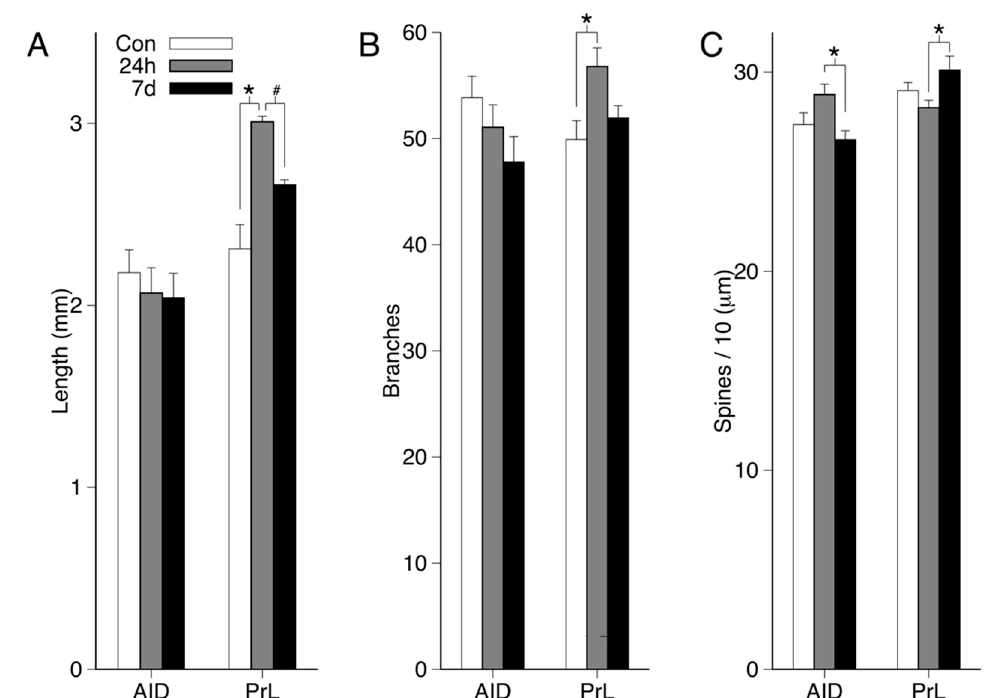
Figure 3. Mean + standard error of the mean (SEM) dendritic length ( A ), branch counts ( B ), and spine density ( C ) for AID and PrL neurons in each group. Values include basilar and apical dendritic fields. Figures 3–5 provide values separately for the basilar and apical dendritic fields (*, p < 0.05, #, p = 0.052).